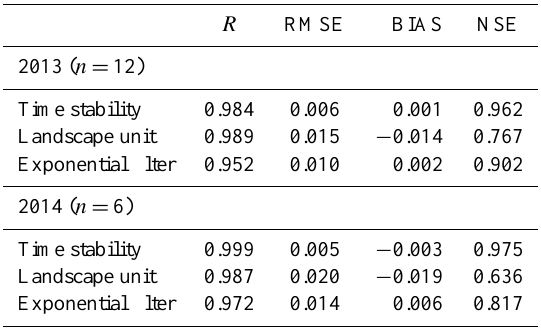
Table 2. Performance metrics of depth-scaling methods using in- strumentation average as the control. Units of RMSE and BIAS are cm 3 cm − 3